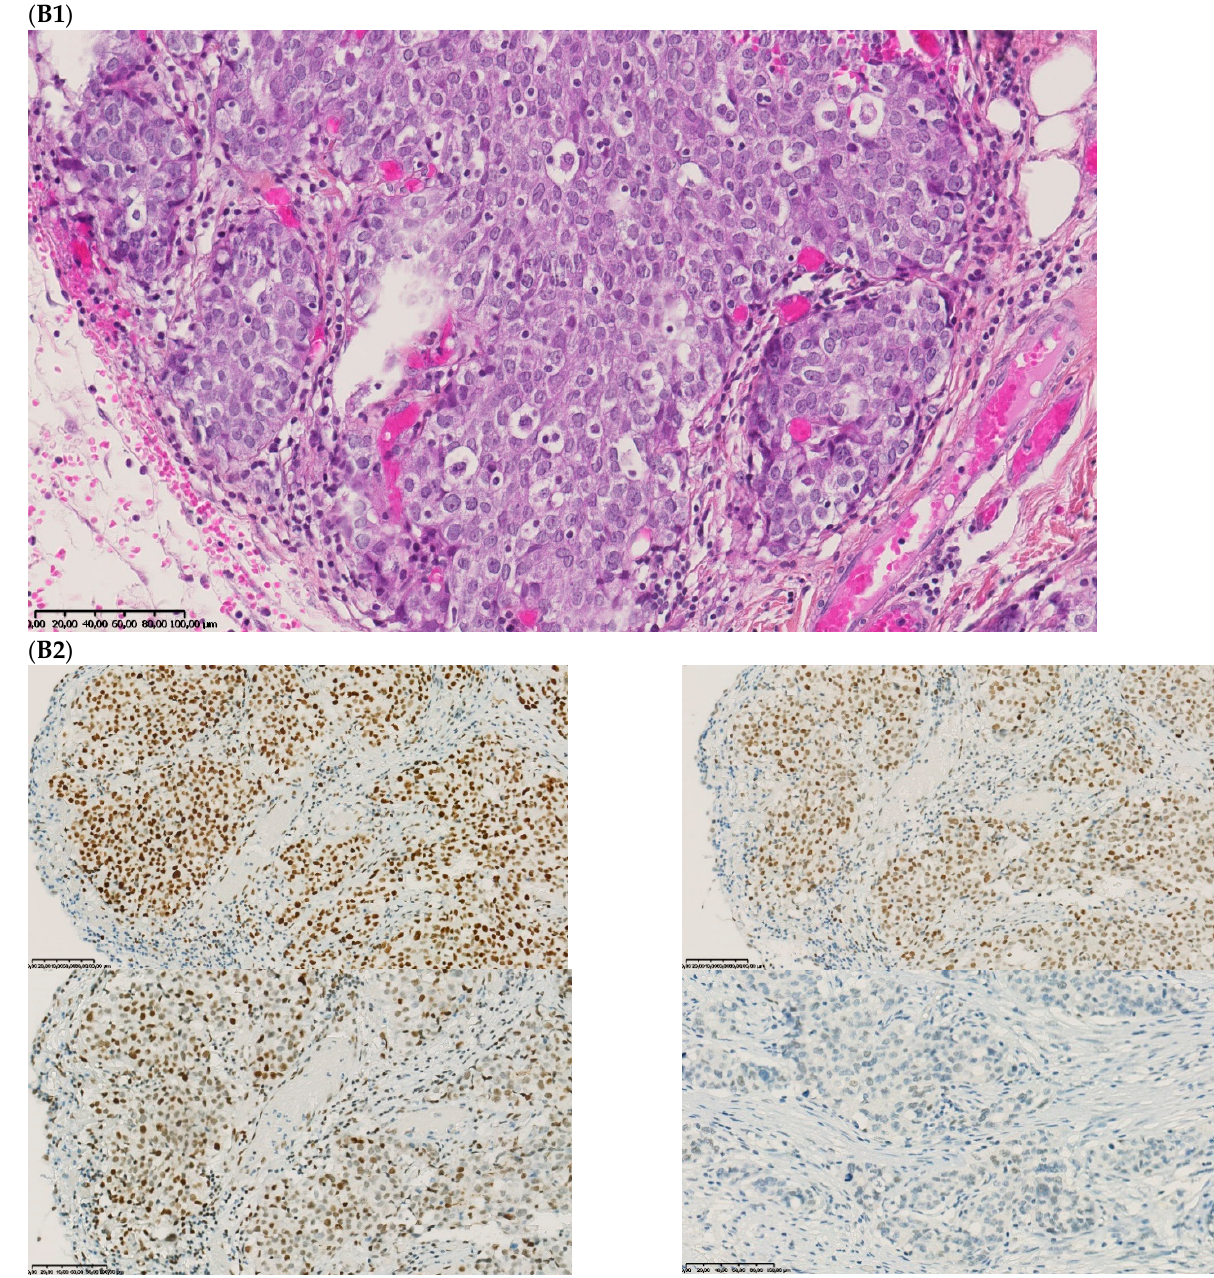
Figure 3. Pathological examination and MMR immunohistochemistry of the discordant case number 4. ( A ) Primary tumor with dMMR status (( A1 ), hematoxylin and eosin stain, 200× magnification) with an expression of MSH2 ( A2, up left ) and MSH6 ( A2, up right ) protein expression and a loss of MLH1 ( A2, down left ) and PMS2 ( A2, down right ). ( B ) Metastatic synchronous peritoneal carcinomatosis with a pMMR status (( B1 ), hematoxylin and eosin stain, 200× magnification) with an expression of MSH6 ( B2, up left , 200× magnification), MSH2 ( B2, up right , 200× magnification), MLH1 ( B2, down left , 200× magnification), and PMS2 ( B2, down right , 300× magnification). IHC: immunohistochemistry; MMR: mismatch repair.